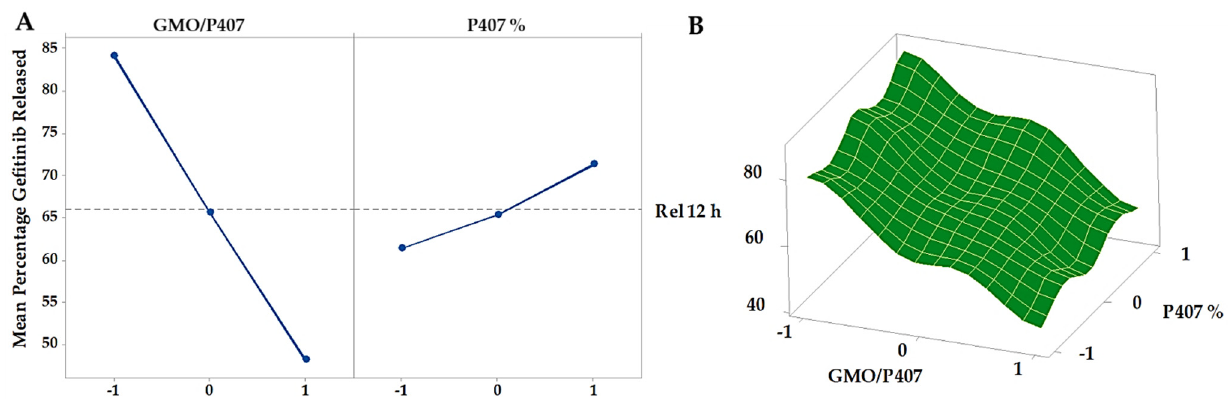
Figure 11. Main effects ( A ) and response surface plots ( B ) of GMO/P407 and P407% on cumulative percentage GFT released.